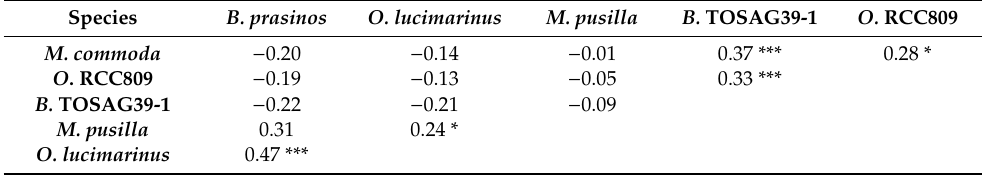
Table 3. Correlations between occurrences of the six Mamiellales genomes.